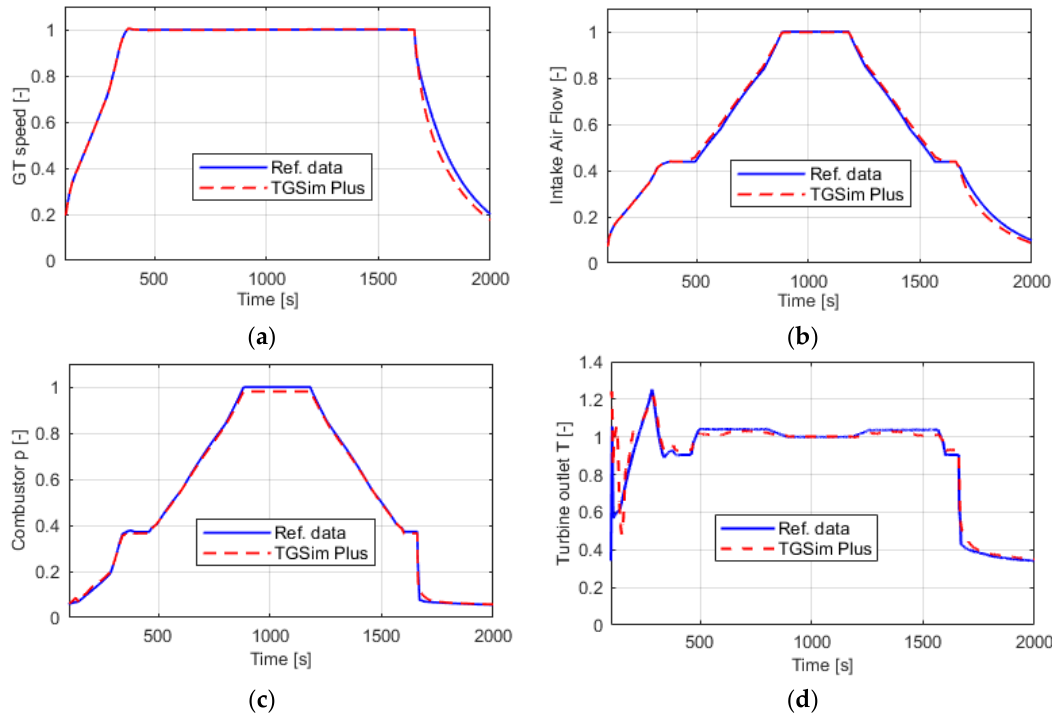
Figure 6. Results of start-up and shutdown simulation. Comparison between reference data (solid blue line) and TGSim Plus™ results (dashed red line). ( a ) Normalised rotational speed, ( b ) Normalised compressor intake mass flow rate, ( c ) Normalised combustor discharge pressure, ( d ) Normalised expander discharge temperature.